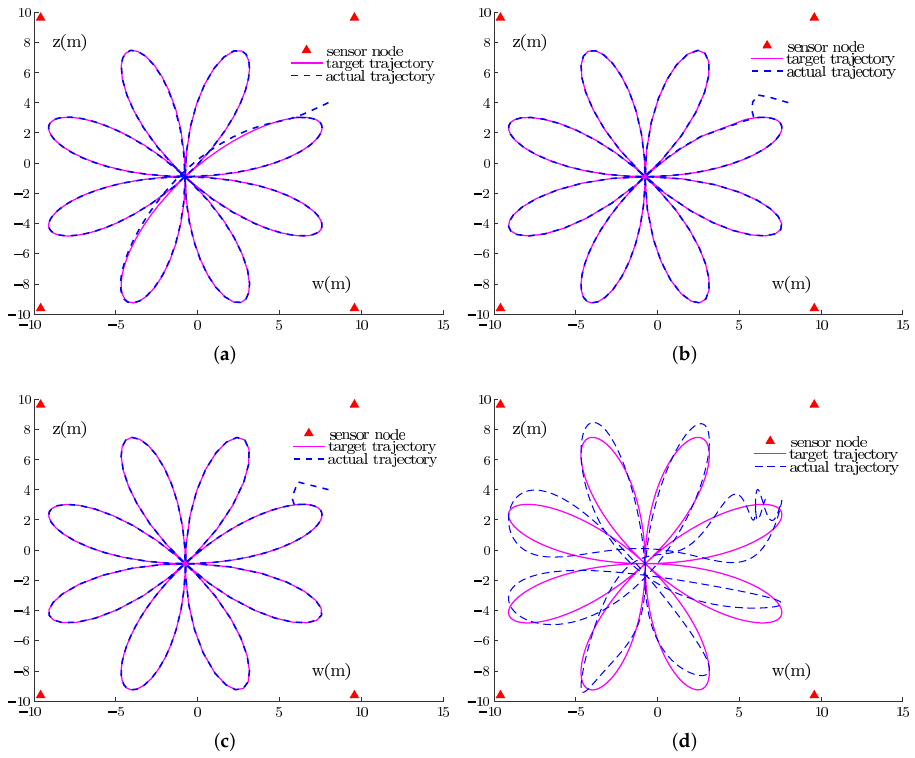
Figure 10. The target trajectories and actual trajectories by the two FPDP models, VPDP model, and the pseudo-inverse method with noise η l ( t ) = sin ( 4 π t + π ) . ( a ) FPDP model with AF (5). ( b ) FPDP model with AF (10). ( c ) VPDP model with AF (12). ( d ) The pseudo-inverse